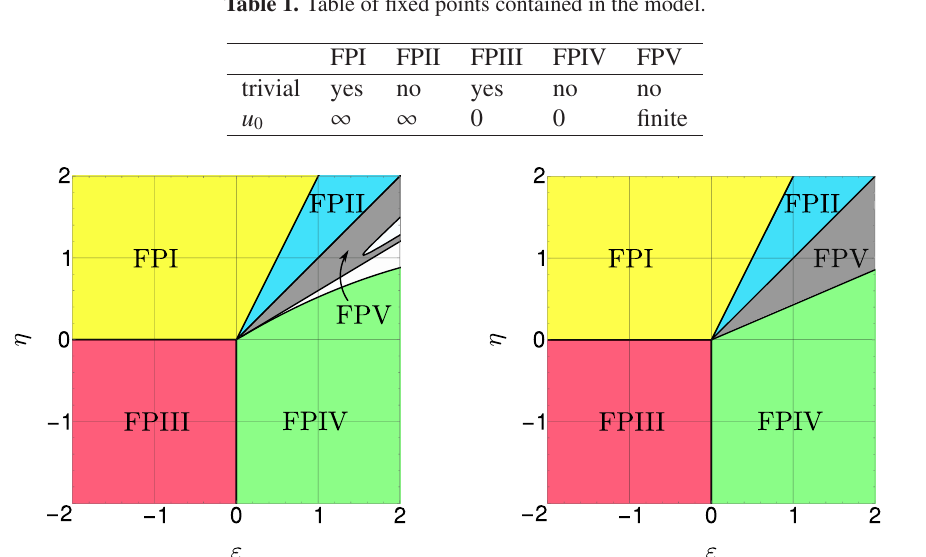
Figure 1. Phase diagram of IR stability regimes for all fixed points of the model under consideration, labeled FPI – FPV, with respect to ε and η for α = 0 . 8 and α = 8 / 7. Boundaries of the fixed points are depicted by thick curves. The white space corresponds to a region of instability that appears for any 0 < α < 8 /